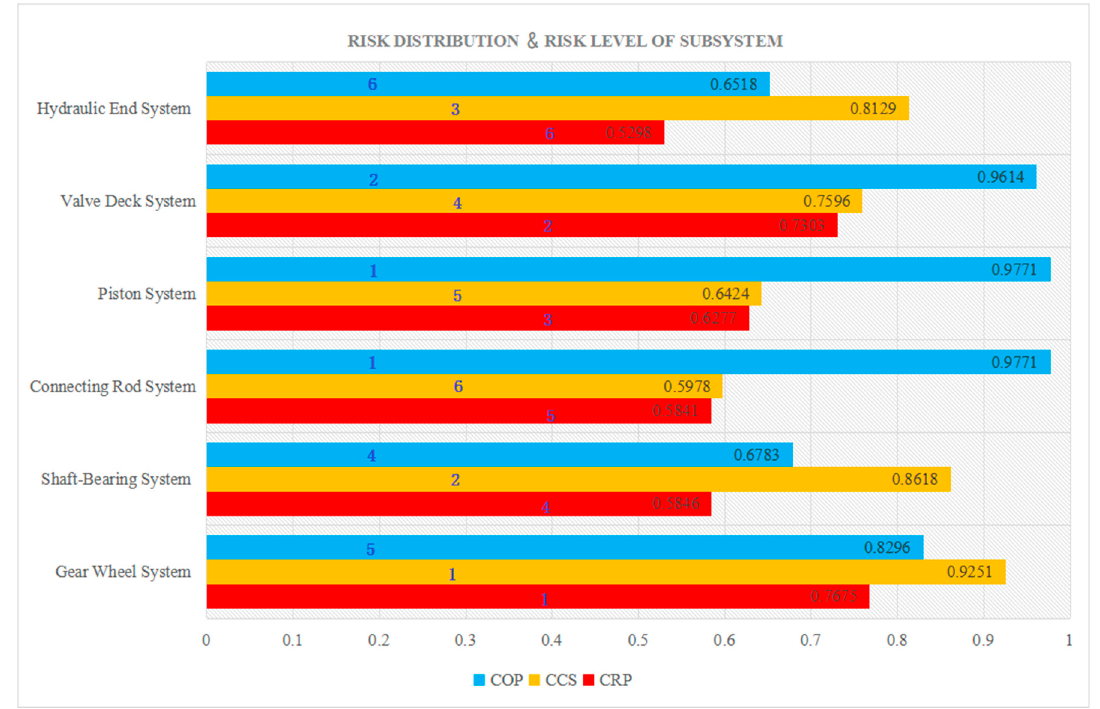
Figure 8. Risk level of the subsystems in the RPS, using crisp occurrence probability (COP), crisp consequence severity (CCS), and crisp risk priority (CRP).